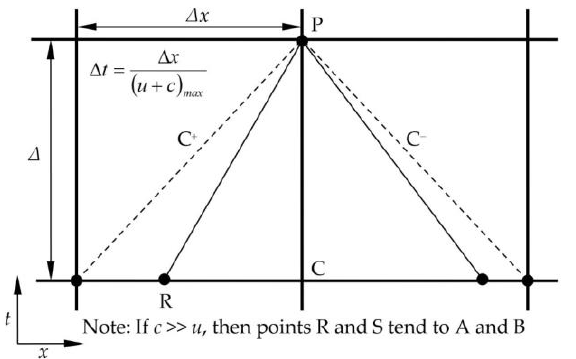
Figure 2. Grid showing characteristic lines as utilized in the method of characteristics approach to air pressure transient